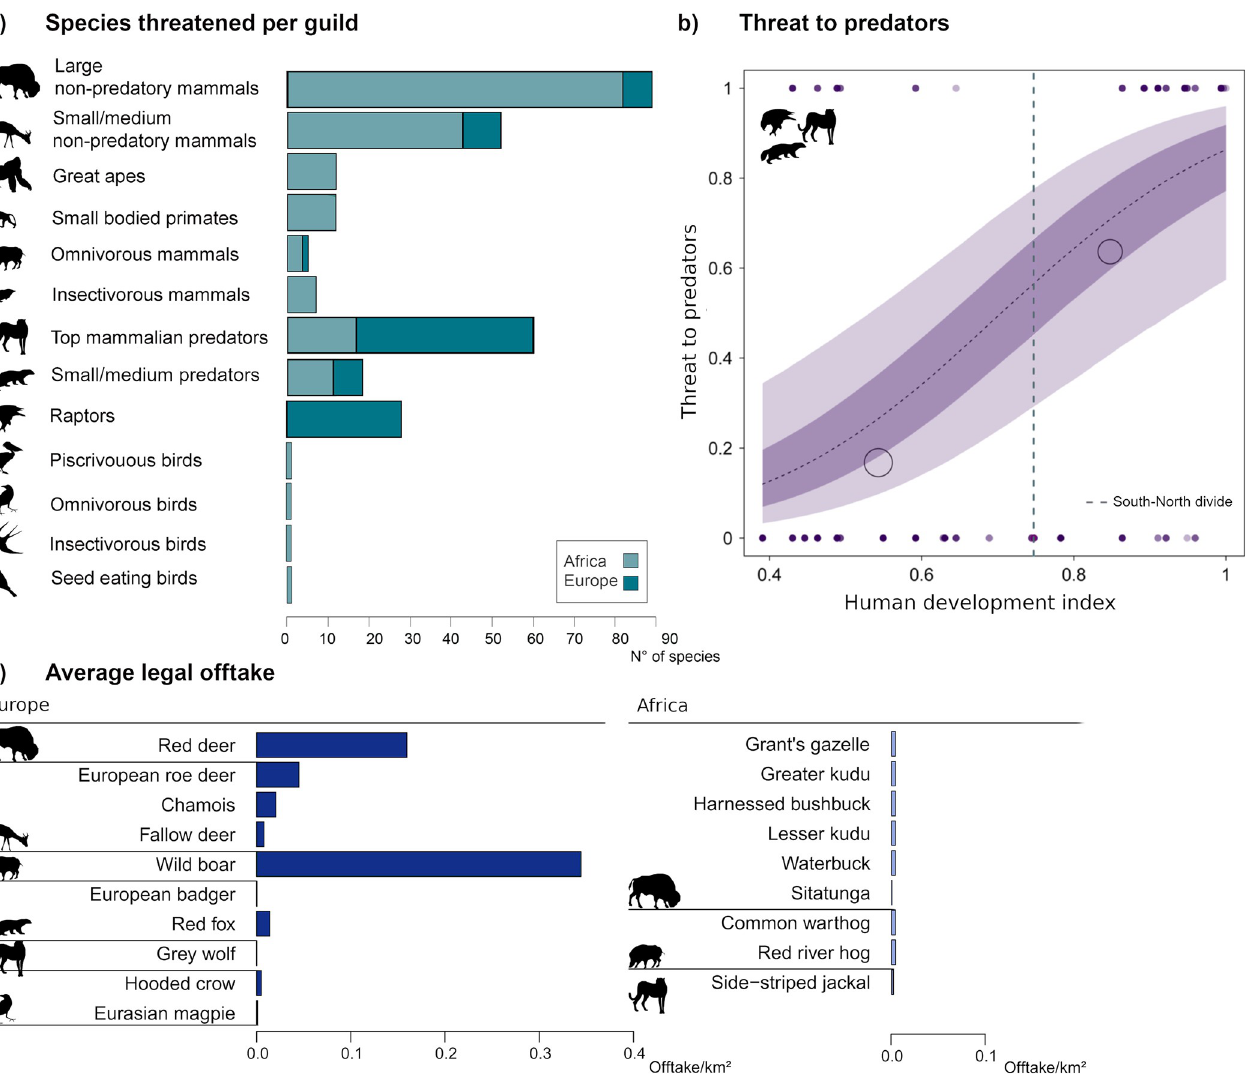
Fig 3. What people hunt. (a) The absolute number of threatened species per guild listed by park managers (includes repeated mentioning of the same species by different managers). In Africa, more herbivorous species, and in Europe, more top mammalian predators and raptors were named. Africa = violet, Europe = turquoise (the data underlying this figure can be found in S2 Data). (b) The probability that a predatory species (top, small to medium predators, raptors) compared to nonpredatory species (all others) were threatened showed an increasing trajectory over the S-N gradient (i.e., HDI) (S7 Data). The dashed line depicts the expected mean of the predicted posterior distribution. The coloured areas describe the 33% and 66% credibility intervals. Transparent points are binned probabilities. The size of the bubbles corresponds to the respective number of PAs. Filled points are original data. The vertical grey dashed line is the Global South-North divide of our data (0.75), (c) the legal offtake per species and square kilometre across European parks (left, turquoise) and across African parks (right, violet) (Table U in S1 Appendix and S3 Data). HDI, Human Development Index; PA, protected area.